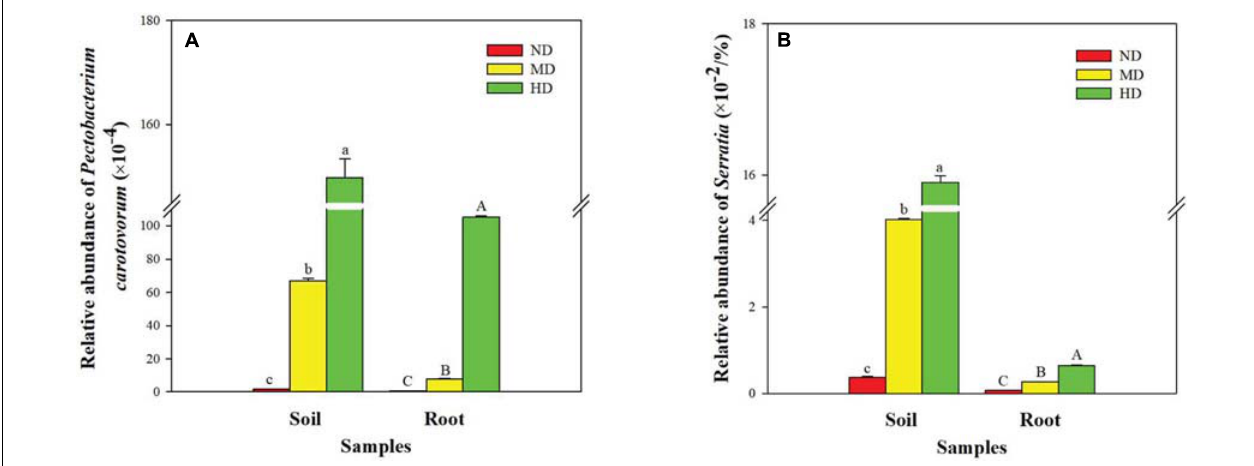
FIGURE 4 | Relative abundance of soft rot pathogens in different soil and root samples. (A) Pectobacterium carotovorum and (B) Serratia . ND, MD, and HD represent the non-diseased, moderately diseased, and highly diseased sites, respectively. Data are expressed as mean ± SD ( n = 3). For each type of samples, different lowercase (soil) or uppercase (root) letters within each group indicate significant differences among the three sampling sites [ p ≤ 0.05; least significant difference (LSD) test].